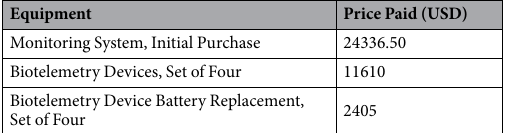
Table 4. Mean cost estimates. Cost estimates for equipment